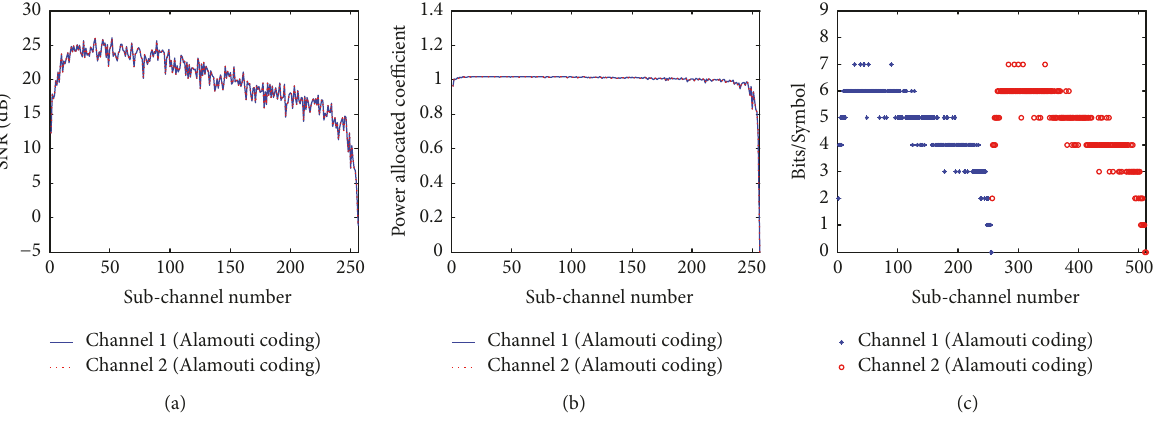
Figure 5: Power and bit allocation results for Alamouti coding system ( K =2.2805, 𝐵𝐸𝑅 T